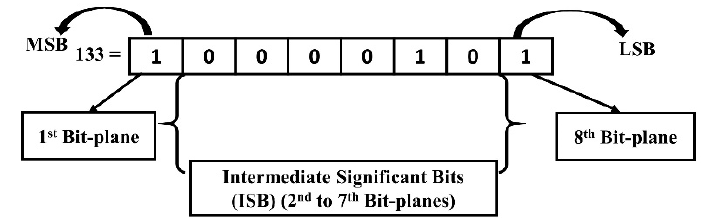
Figure 10. A bit-plane of a digital image.